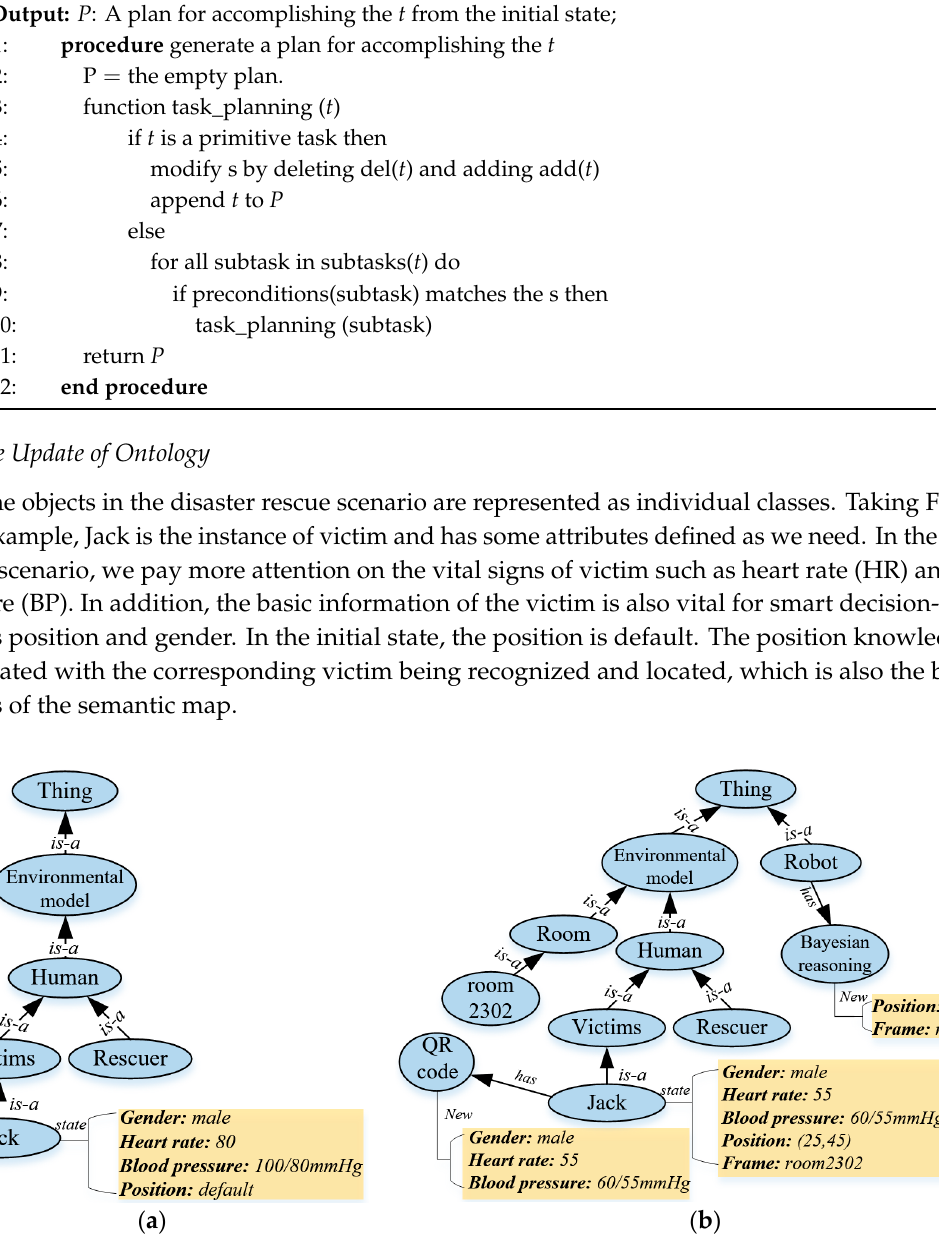
Figure 10. The knowledge representation in environment ontology. ( a ) The structure of environment ontology; ( b ) the knowledge update in environment ontology.